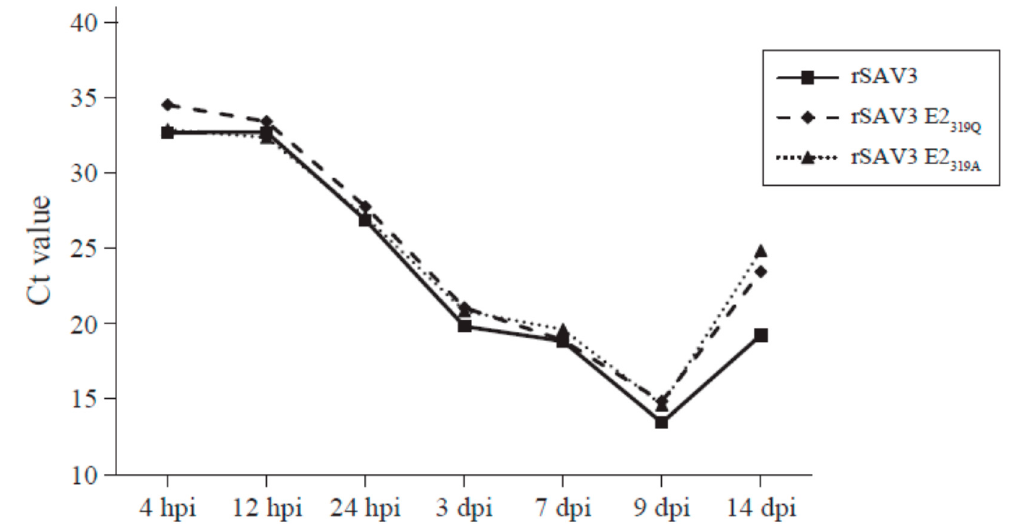
Figure 7. Viral Ct values of CHH-1 cells infected with rSAV3, rSAV3 E2 319Q and rSAV3 E2 319A